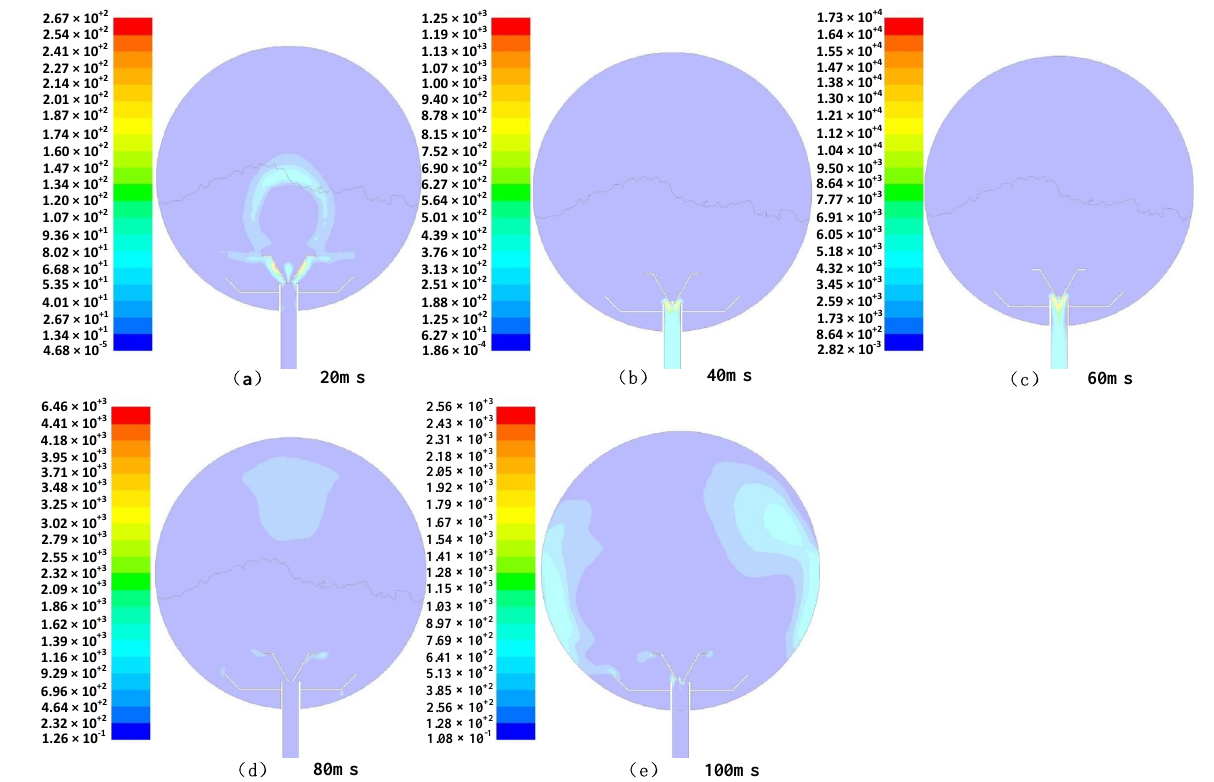
Figure 11. Dynamic pressure evolution before and after ignition and explosion. As shown in Figure 12, the degree of turbulence at the inlet was the greatest at the initial moment, and with increasing dusting time, the turbulence was the most intense in the area close to the ignition point, with turbulence intensity have a large gradient. After ignition, the gradient of turbulence intensity decreased sharply, and the turbulent gradi- ent increased again at the end of deflagration. This is mainly due to the molecular activity of the gas mixture of the sphere reaching the highest peak at the highest temperature, and the turbulent kinetic energy also reaching its maximum value at this time.